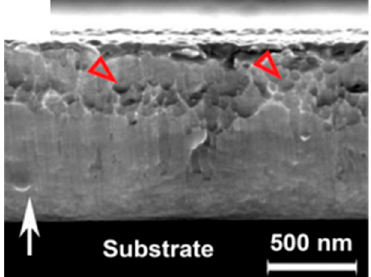
Figure 11. Fractography of Cu/Au multilayer specimens with h = 25 nm. The shearing direction is indicated by white arrows [67].